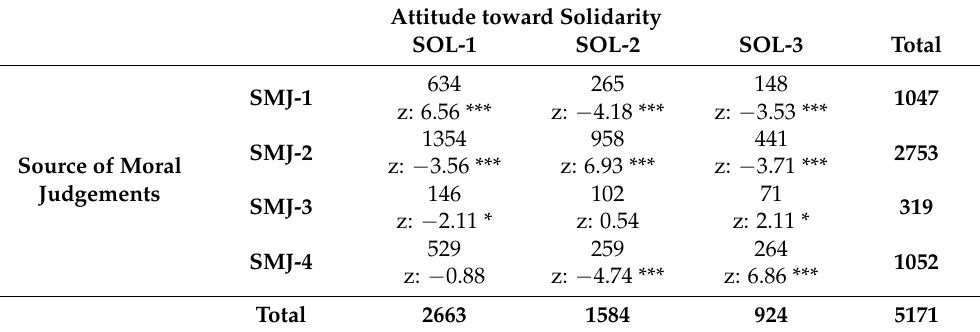
Table 10. Relationship between solidarity (SOL) and source of moral judgements (SMJ). Attitude toward Solidarity SOL-1 SOL-2 SOL-3 Total